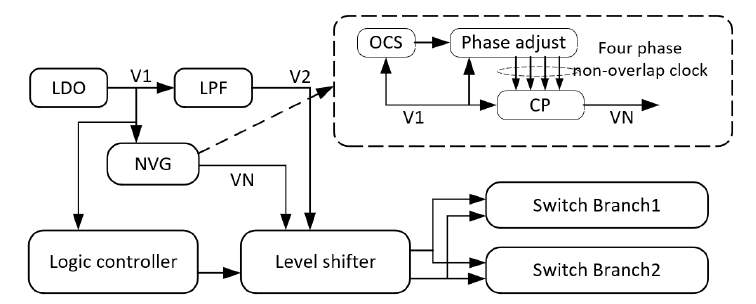
Figure 8. Diagram of the RF switch chip.